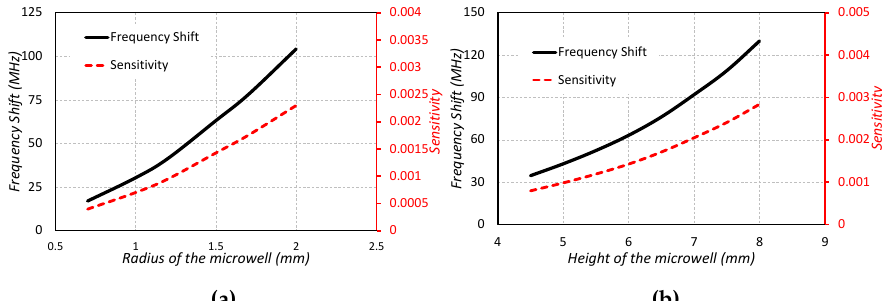
Figure 7. Type1: Frequency shift and sensitivity against ( a ) Radius of the microwell ( b ) Height of the